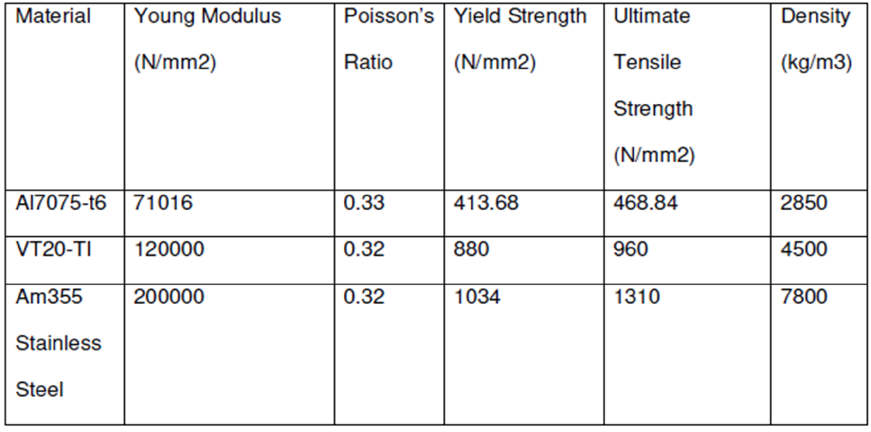
Figure 7. Material properties for the wing root joint.